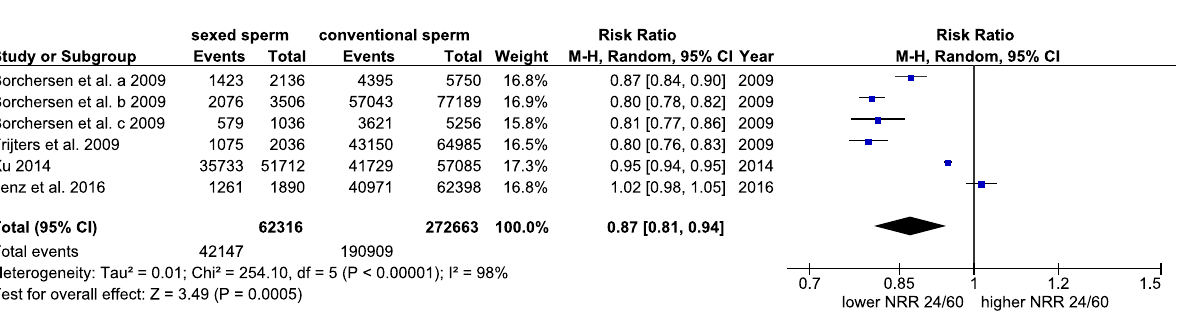
Figure 2. Forest plot of the non-return rates (NRR) 24/60 after the use of sex-sorted sperm compared to conventional